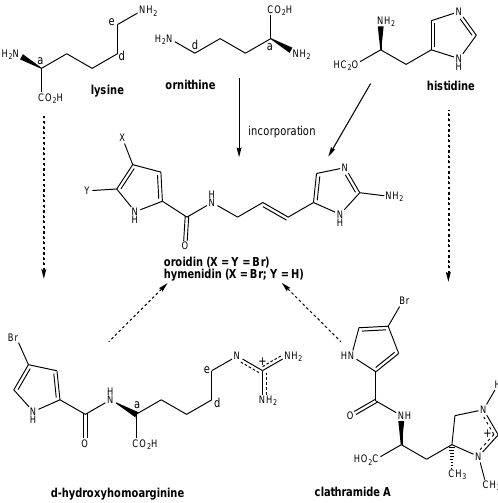
Figure 4. Plausible biosynthetic pathways leading to the key pyrrole-imidazole alkaloid (according to Hoffmann and Lindel, 2003).